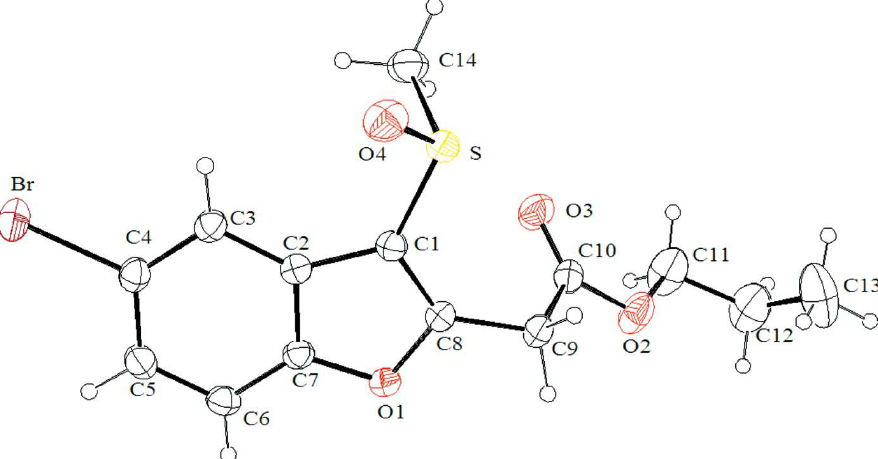
Figure 1 The molecular structure of the title compound, showing displacement ellipsoids drawn at the 30% probability level.